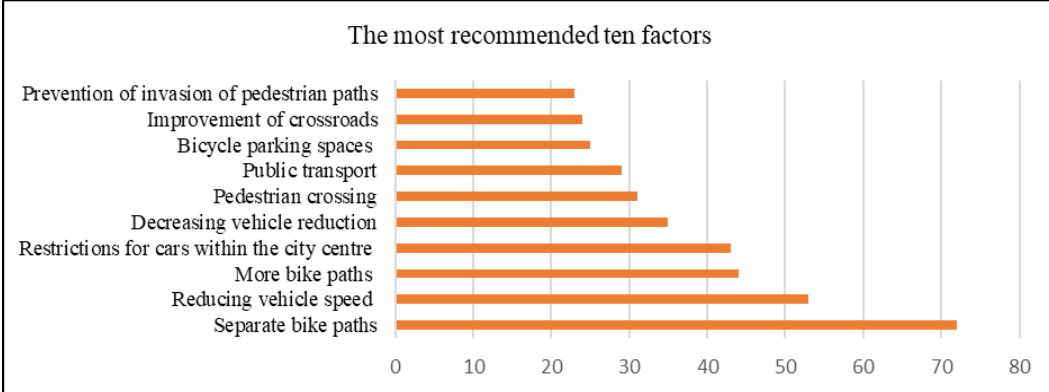
Figure 1. The most recommended 10 factors for Turkish transport visions.